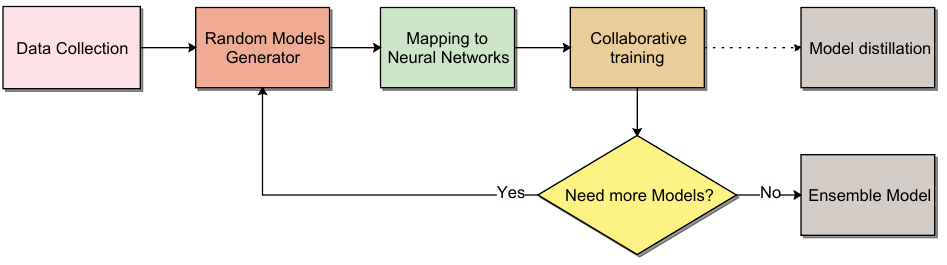
Figure 1. The components of the proposed system. First, we collect the training labeled data. Second, a chain of randomly wired models is created. Third, the models are mapped to neural networks and, then, trained collaboratively. Finally, we produce a set of models that are co-distillation. We could also produce a multiple set of random models and combine them to form a robust ensemble